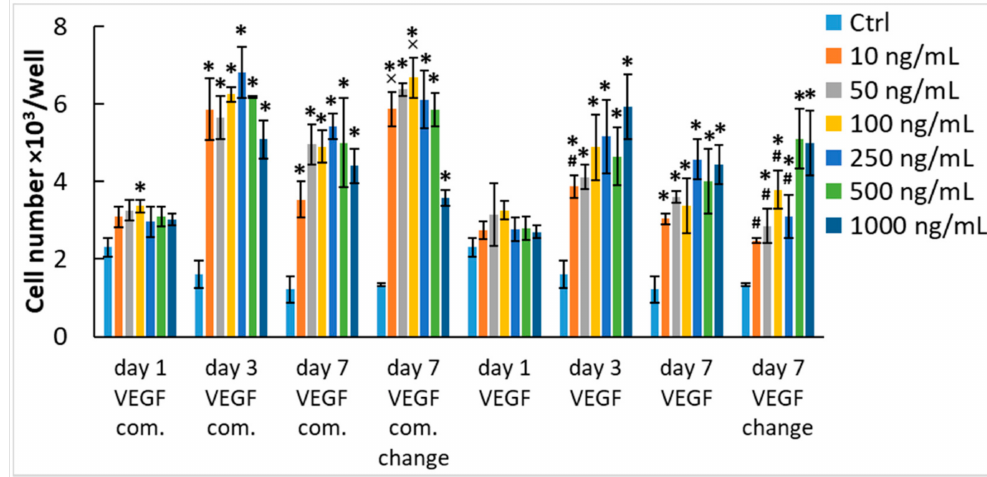
Figure 3. The effect of medium exchange on the mitogenic activity of VEGF-A 165 diluted in the culture medium. The HUVECs were grown in media enriched with commercial VEGF-A 165 (VEGF com.) or our recombinant VEGF-A 165 in the concentration range from 10 to 1000 ng/mL. VEGF-A 165 was added into EGM2-weak. Control cells were grown in media without growth factors (Ctrl). The cell number was determined on days 1, 3, and 7 after seeding. In some of the samples, the medium containing the corresponding concentration of growth factor was exchanged for a fresh one on day 3 after cell seeding. Mean ± SD from 3 wells. Holm–Sidak method, p ≤ 0.05. The samples were statistically compared on the indicated day after seeding. Statistically significant differences are depicted above the columns. * statistically significant difference versus control sample (Ctrl). # statistically significant difference versus sample containing the corresponding concentration of commercial growth factor. × statistically significant difference versus sample containing the corresponding concentration of growth factor without medium